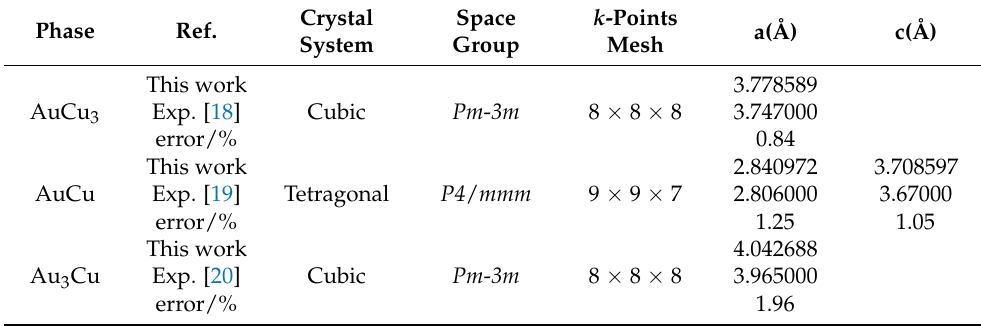
Table 1. Calculated and experimental lattice constants of Au–Cu IMCs.